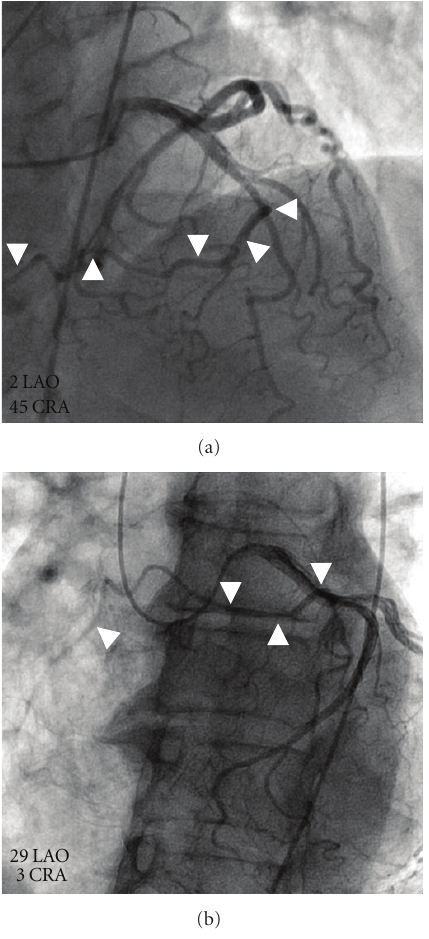
Figure 1: With conventional coronary angiography, an anomalous vessel originating from the mid-LAD was observed, coursing away for the circumflex coronary artery (white arrows in (a) and (b)). CRA indicates cranial; LAO: left anterior oblique.